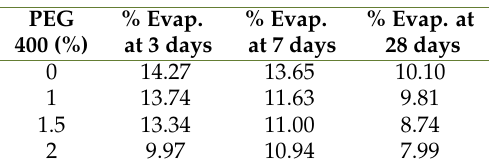
Table 1. Percentage Evaporation at 0.34 Water-Cement Ratio. PEG %